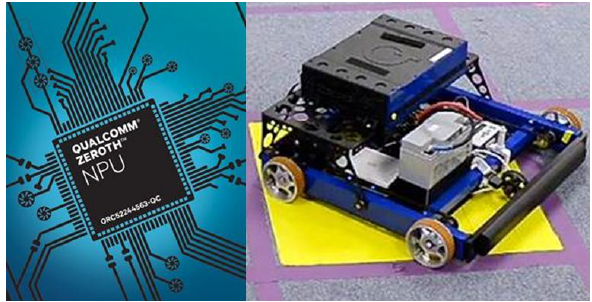
Figure 5: Qualcomm Neurochip and a robot using the chip (Neuro